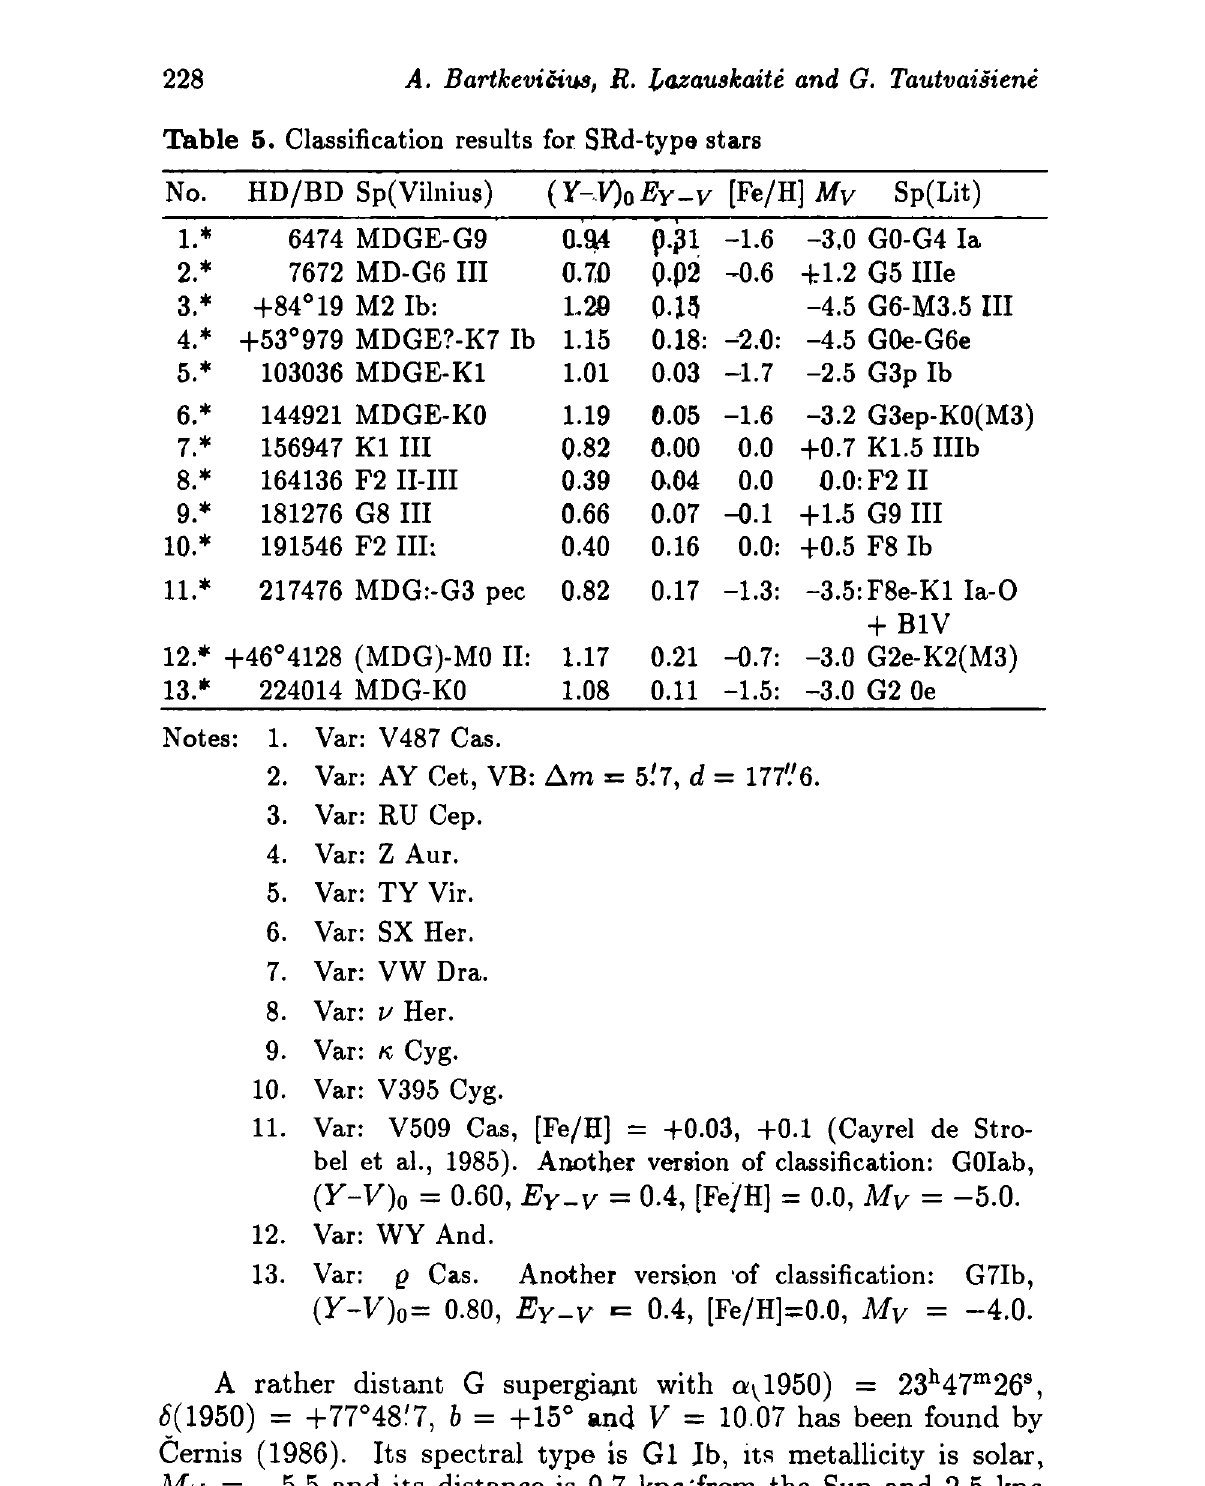
Table 5. Classification results for SRd-typa